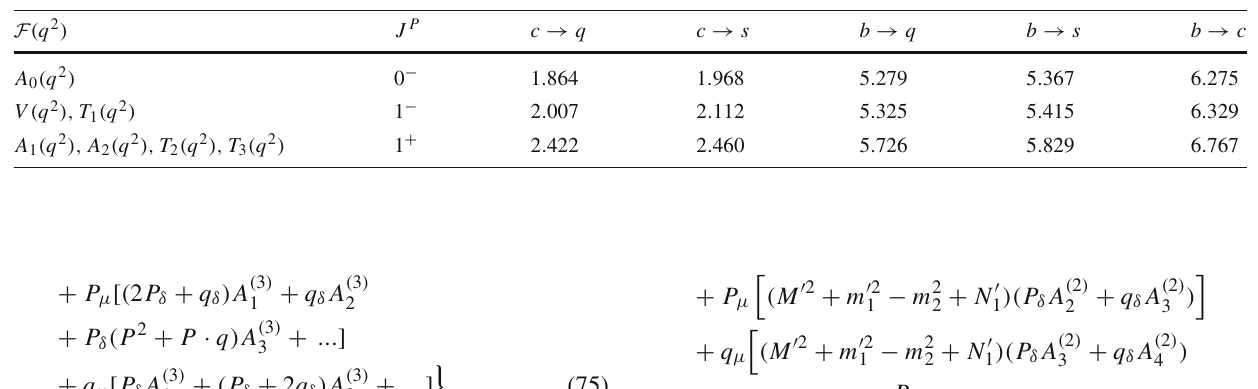
Fig. 3 The dependences of d [ T 3 ] z . m . / d x on x for D → K ∗ 2 transition at q 2 ⊥ = ( 0 , 0 . 2 ) GeV 2 and for B c → D ∗ transition at 2